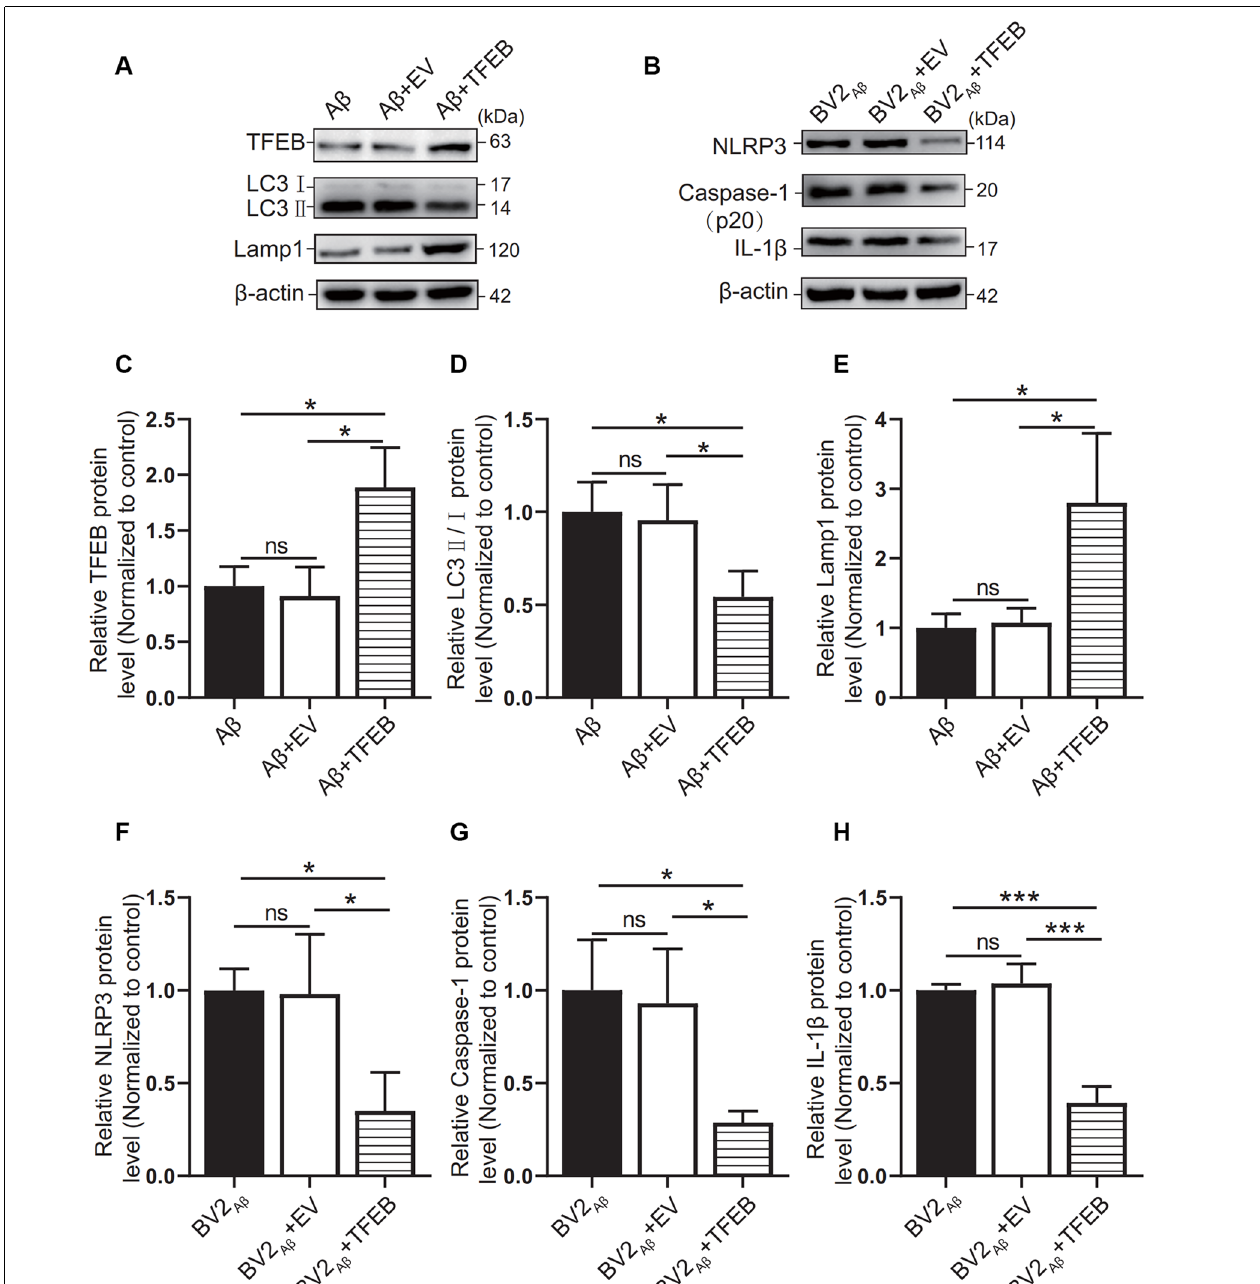
FIGURE 7 | Effects of TFEB overexpression on autophagy in SH-SY5Y cells supplemented with A β 25–35 . After overexpression of the TFEB protein in the control group or A β 25–35 group cocultured with BV2, (A) the expression of the TFEB, LC3, and Lamp1 proteins in the A β group, the A β + EV group, and the A β + TFEB overexpression adenovirus group was observed by Western blots, and (C–E) the relative gray values of each group were compared. (B) Western blotting was used to observe NLRP3, caspase-1, and IL-1 β protein expression in BV2 cells, and (F–H) the relative gray values of each group were compared (* p < 0.05, *** p < 0.001; “ns” means there is no significant difference; n =